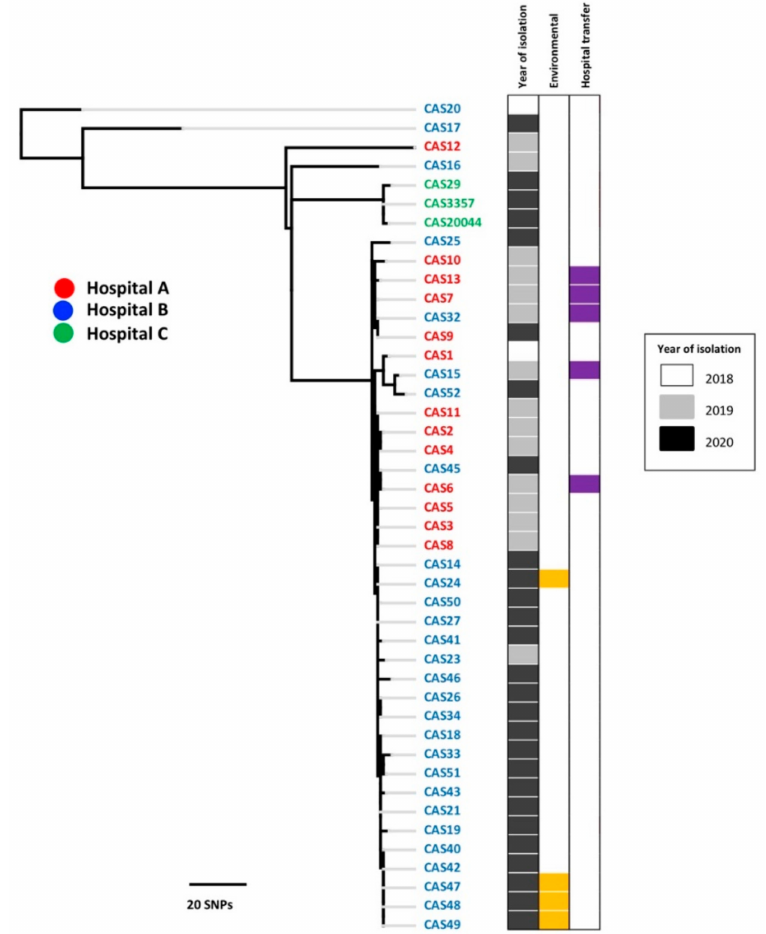
Figure 1. Genetic relationships of the 44 Candida auris isolates. Comparison of all Qatar isolates based on high-resolution variants. The color blocks highlight the year of isolation, environmental isolates, and hospital